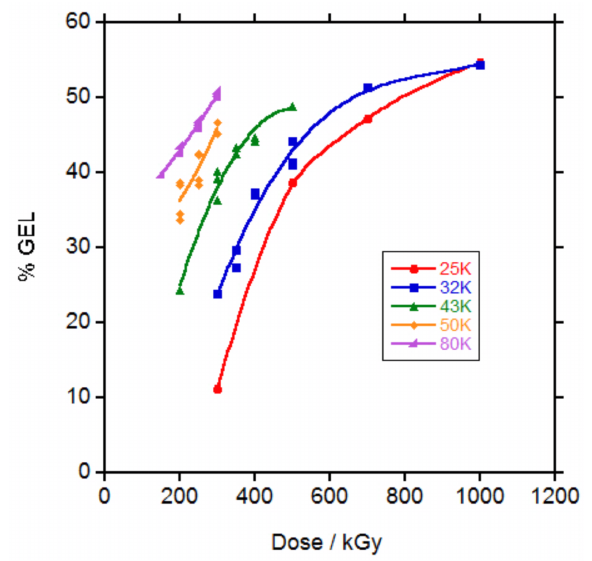
Figure 1. Gel percentage in the irradiated polycaprolactones (PCLs) vs